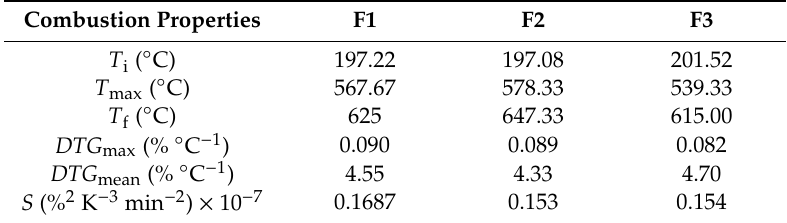
Table 3. Combustibility characteristic parameters of furanic-glyoxal